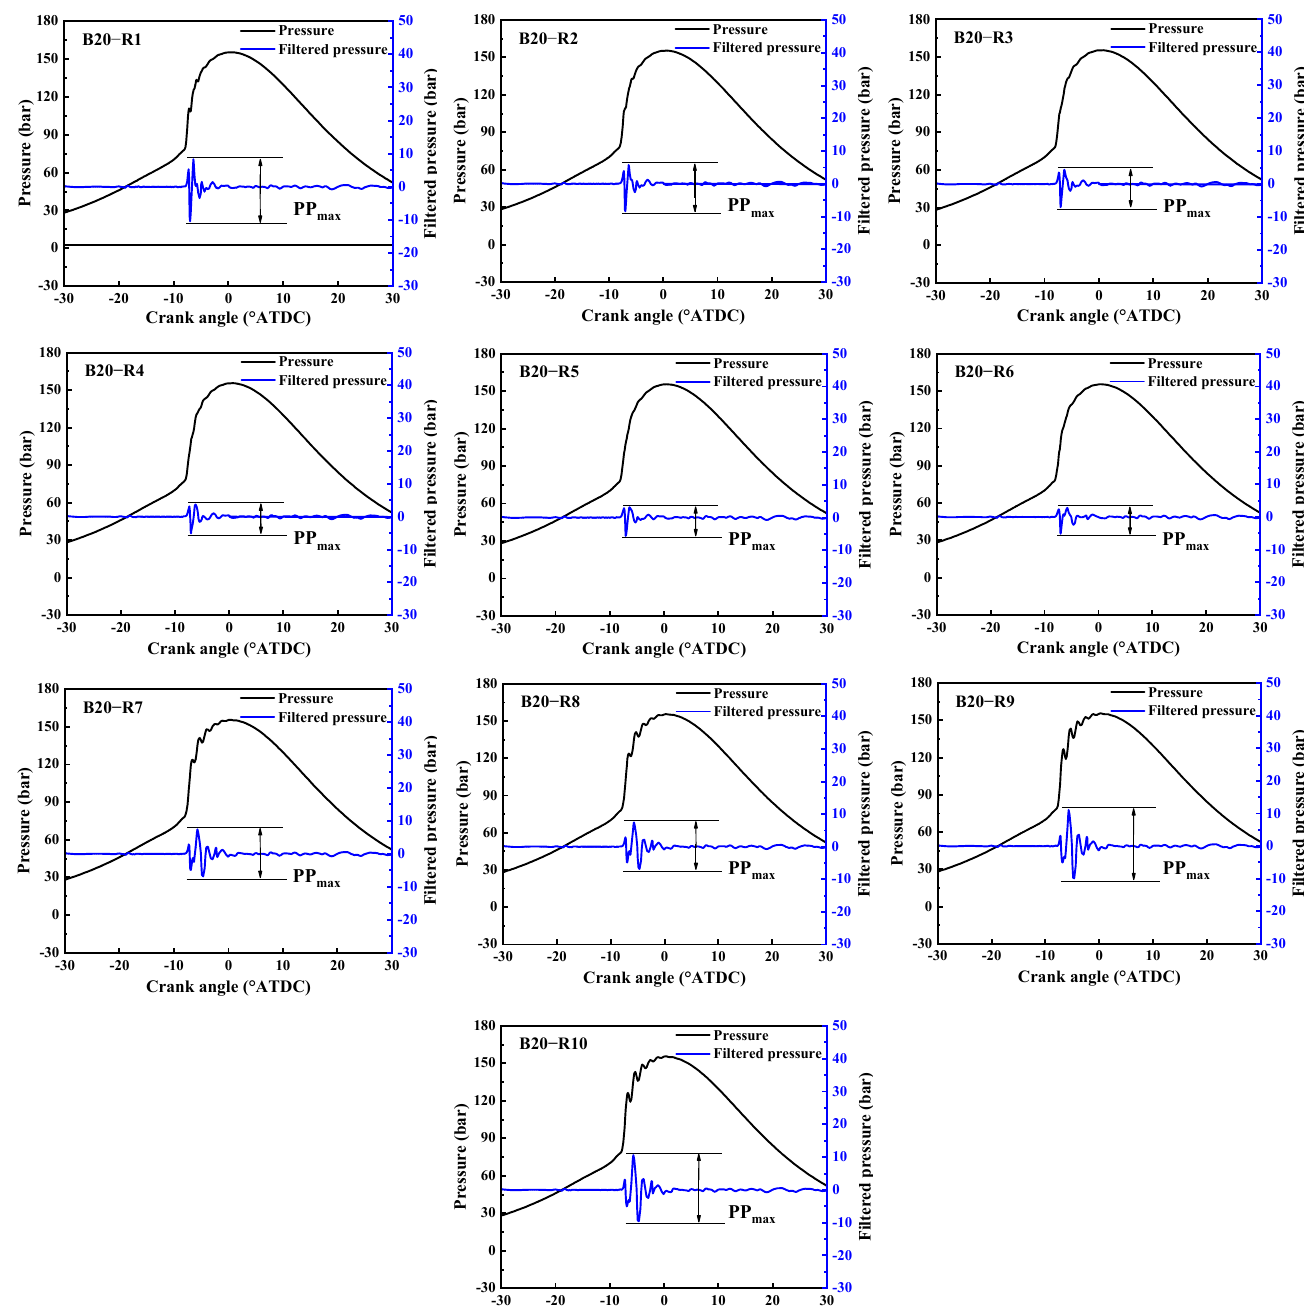
Figure 4. Comparison of local in-cylinder pressure and maximum pressure PP max in regions R1–R10 under B20 working conditions.